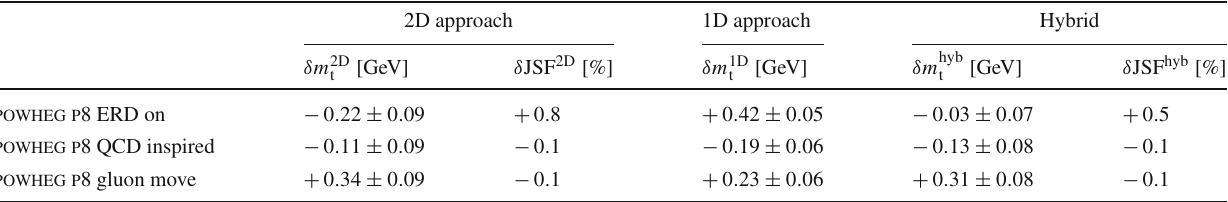
Table 1 Observed shifts with respect to the default simulation for different models of color reconnection. The “QCD inspired” and “gluon move” models are compared to the default model with ERDs. The statistical uncertainty in the JSF shifts is 0.1%